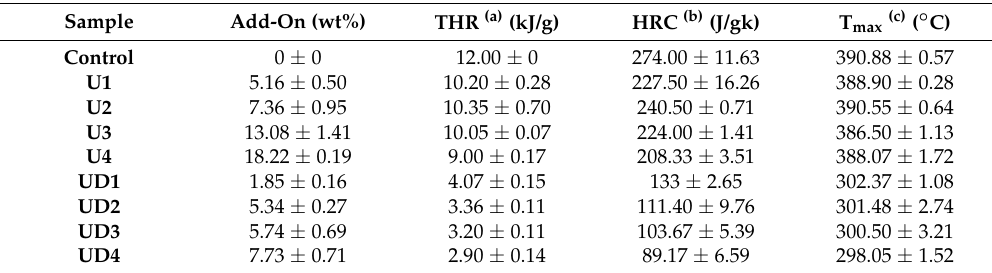
Figure 4. Microscale combustion calorimeter (MCC) graphs of heat release combustion curves for control, ( a ) urea only treated samples, U1–U4 and ( b ) urea/DAP treated sample, UD1–UD4 fabrics. Table 4. Microscale combustion calorimetry (MCC) data of control and treated fabrics (reported value is the average from three observations).